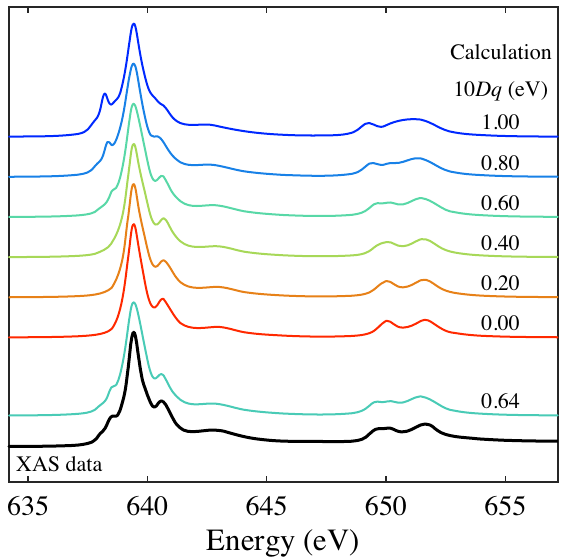
FIG. 7. Mn L 2 x-ray absorption spectrum of α -MnS (black ; 3 line) and simulations for different values of 10 Dq . The best fit is obtained for 10 Dq ¼ 0 . 64 eV (turquoise line).